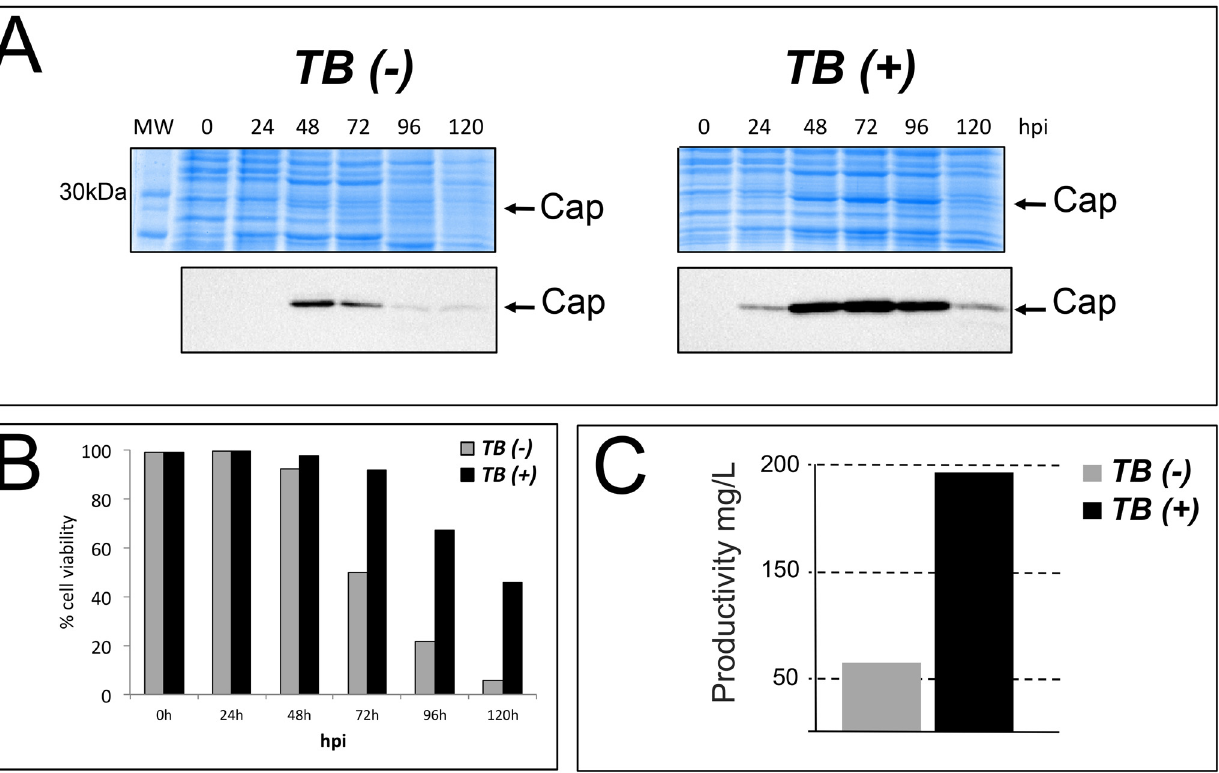
Fig 2. Production of the PCV2-Cap protein in Sf9 cells grown in suspension and infected by a conventional TB(-) or by a TB (+) baculovirus expressing the ORF2 from porcine circovirus gene. A) Coomassie blue staining of SDS-PAGE gels resolving protein extracts obtained from cells infected with TB(-) or TB(+) baculoviruses and collected from 0 to 120 hpi. The same samples were submitted to a Western blot using a monoclonal antibody against the PCV2-Cap antigen. B) Infected cells viability at different hpi with TB(-) and TB(+) baculoviruses expressing the PCV2-Cap protein, analyzed by Trypan blue staining. This panel represents the mean values of three different experiments. C) Calculation of PCV2-Cap protein productivity in Sf9 cells infected by TB(-) and TB(+) baculoviruses at the optimal production time in each case (24 hpi for TB(-) and 48 hpi for the TB(+) baculovirus).